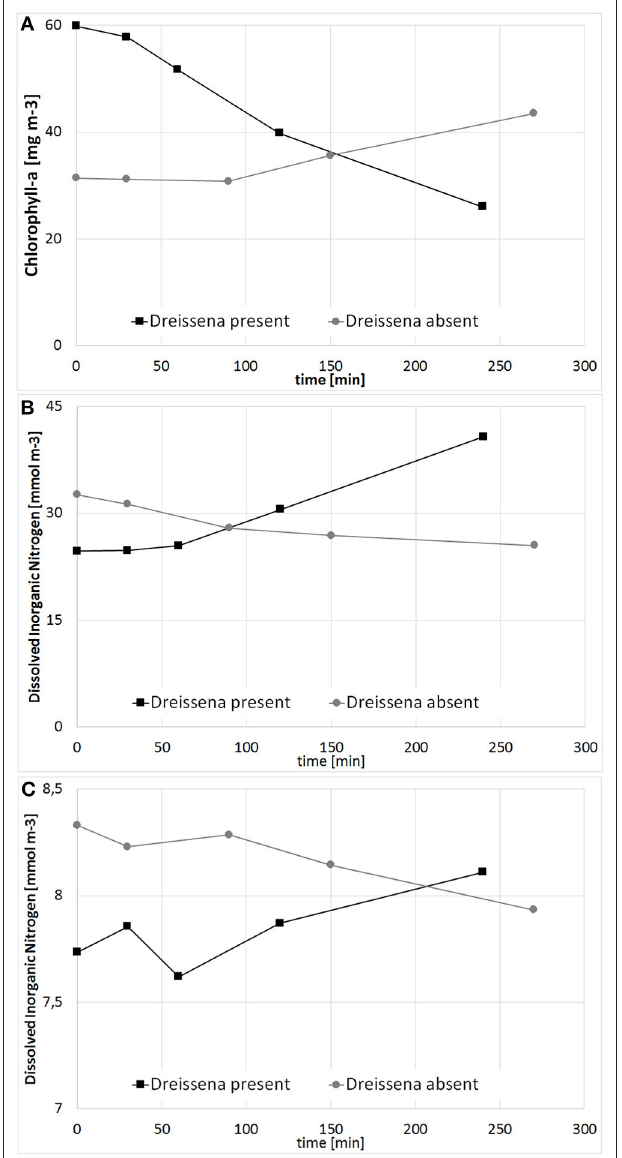
FIGURE 6 | Change of Chlorophyll a ( A ; mg m − 3 ), Dissolved Inorganic Nitrogen ( B ; mmol m − 3 ) and Phosphorus ( C ; mmol m − 3 ) in a filtration experiment with and without Dreissena polymorpha .